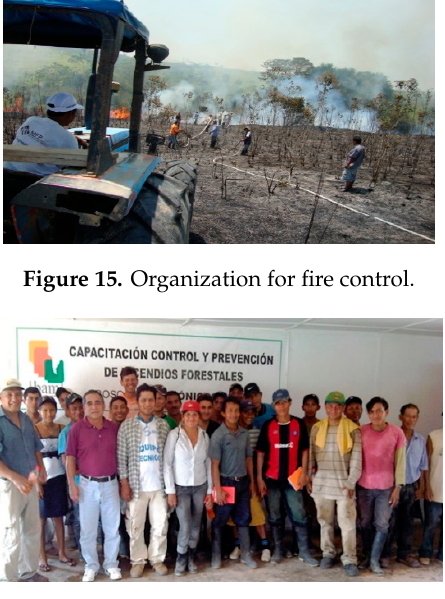
Figure 17. Dipteryx ferrea and Simarouba amara in one of the management units planted in 2008/2009.